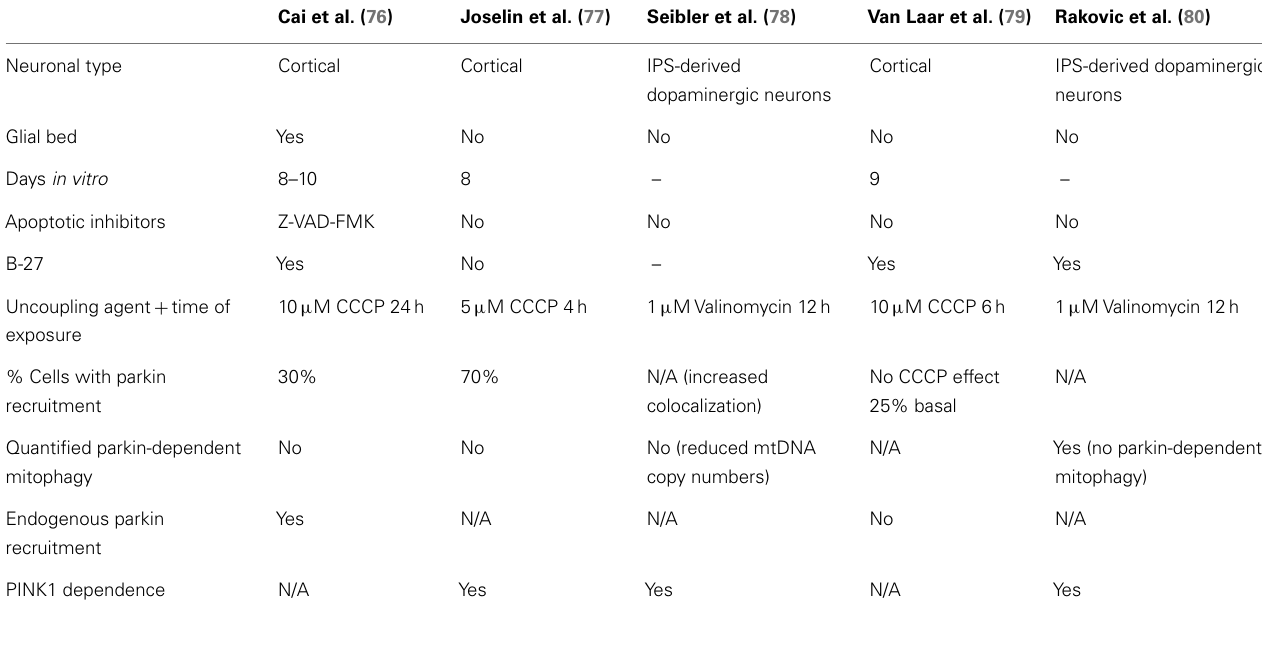
Table 2 | Comparison of data on Parkin/PINK1-dependent mitophagy in